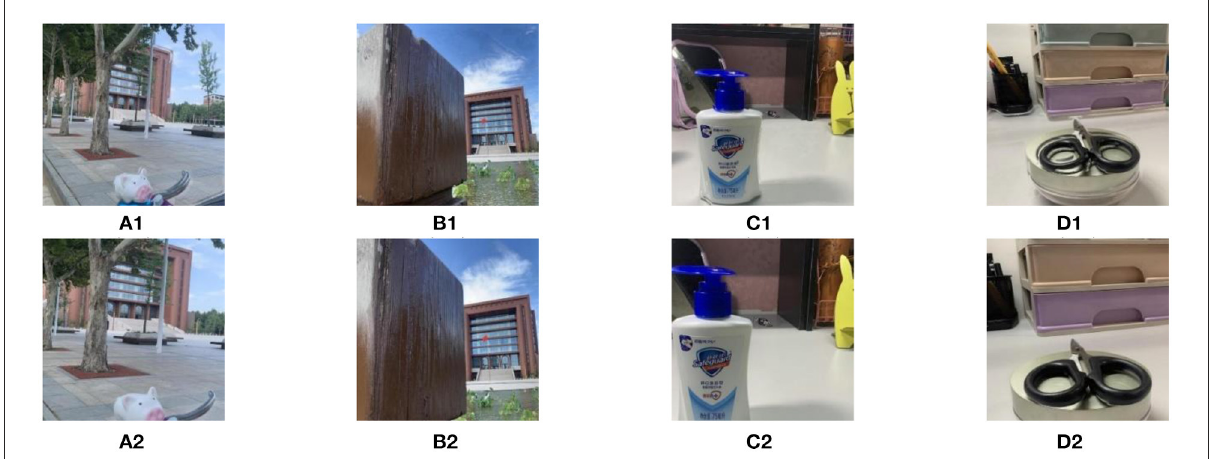
FIGURE3 The fusion results before and after image registration. (A1–D1) are the fused images for the multi focus image pair without registration processing. (A2–D2) are the fused images by registration images.